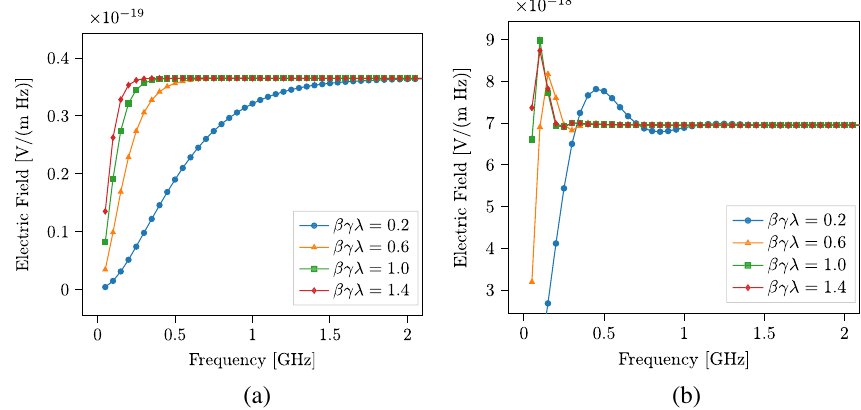
FIG. 3. (a) Frequency response as a function of target size for β ¼ 0 . 05 at monitor distance R ¼ 2 . 0 m. (b) Frequency response as a function of target size for β ¼ 0 . 9 at monitor distance R ¼ 2 . 0 m.